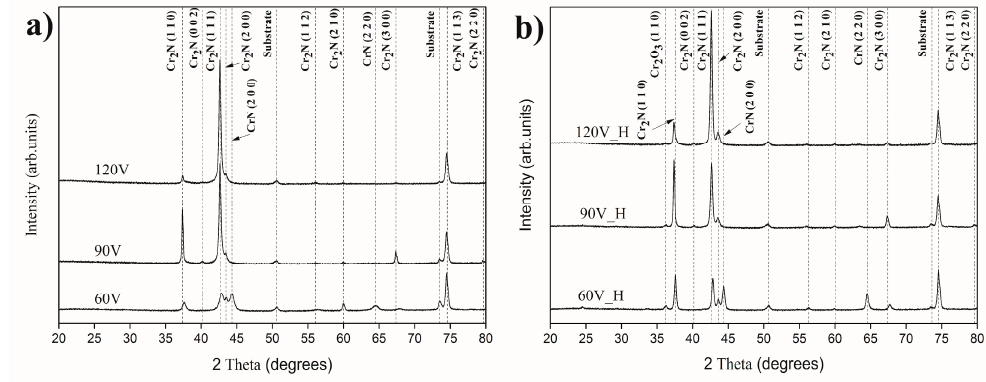
Figure 4. XRD of CrN x coatings deposited at different substrate bias ( a ) before and ( b ) after hydrogenation.